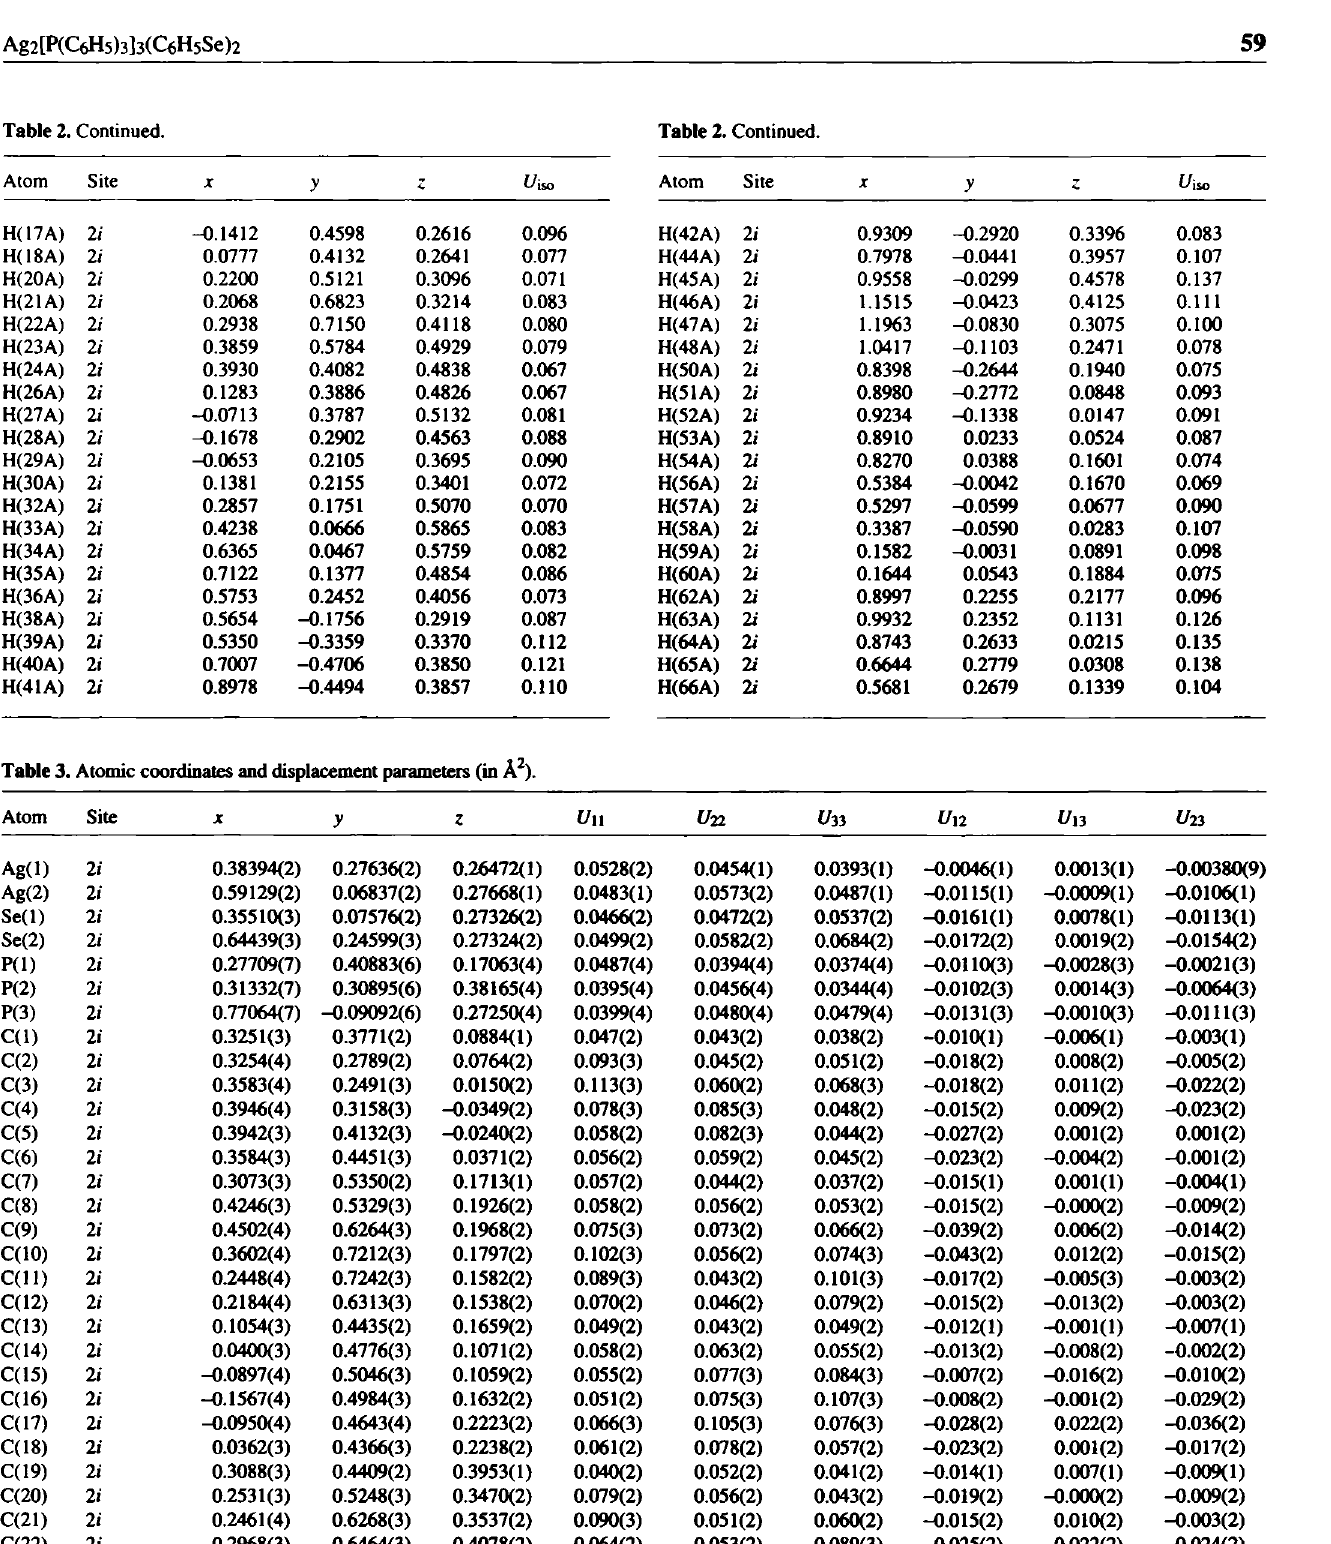
Table 3. Atomic coordinates and displacement parameters (in Ä 2